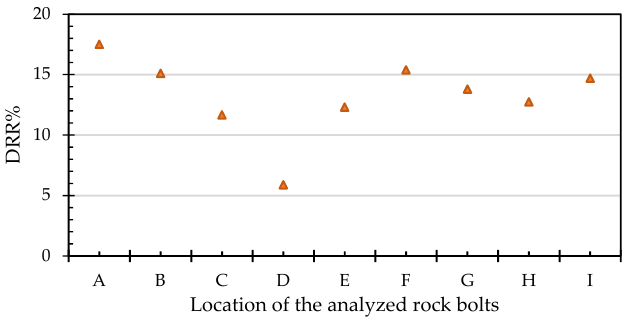
Figure 31. DRRs at various locations with rock bolts.